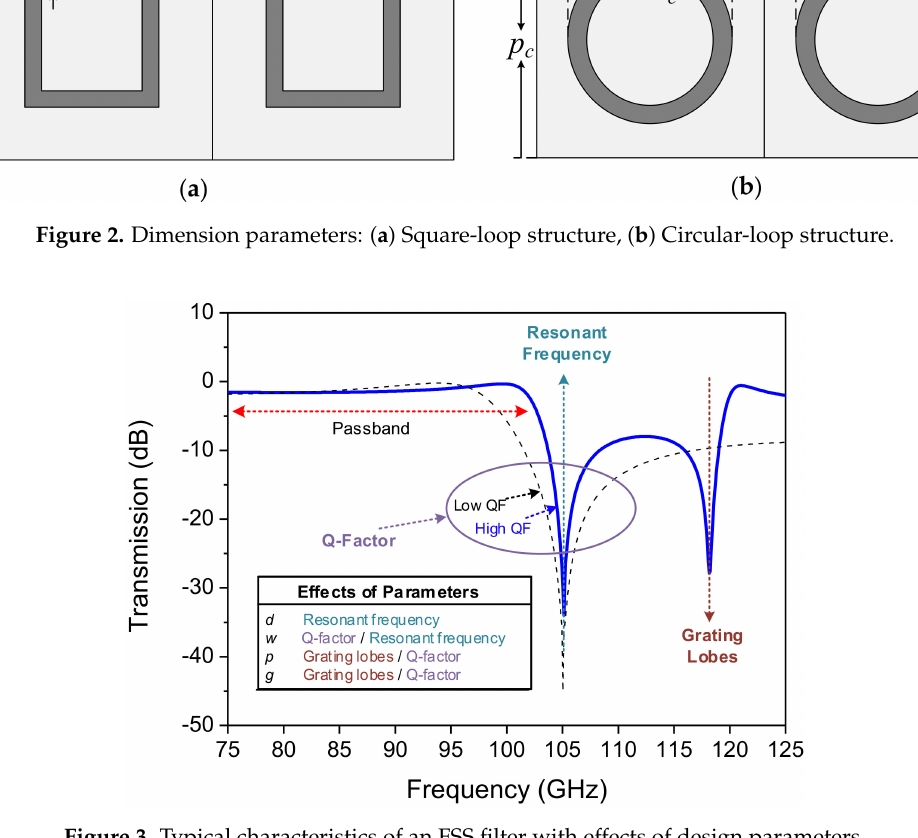
Figure 3. Typical characteristics of an FSS filter with effects of design